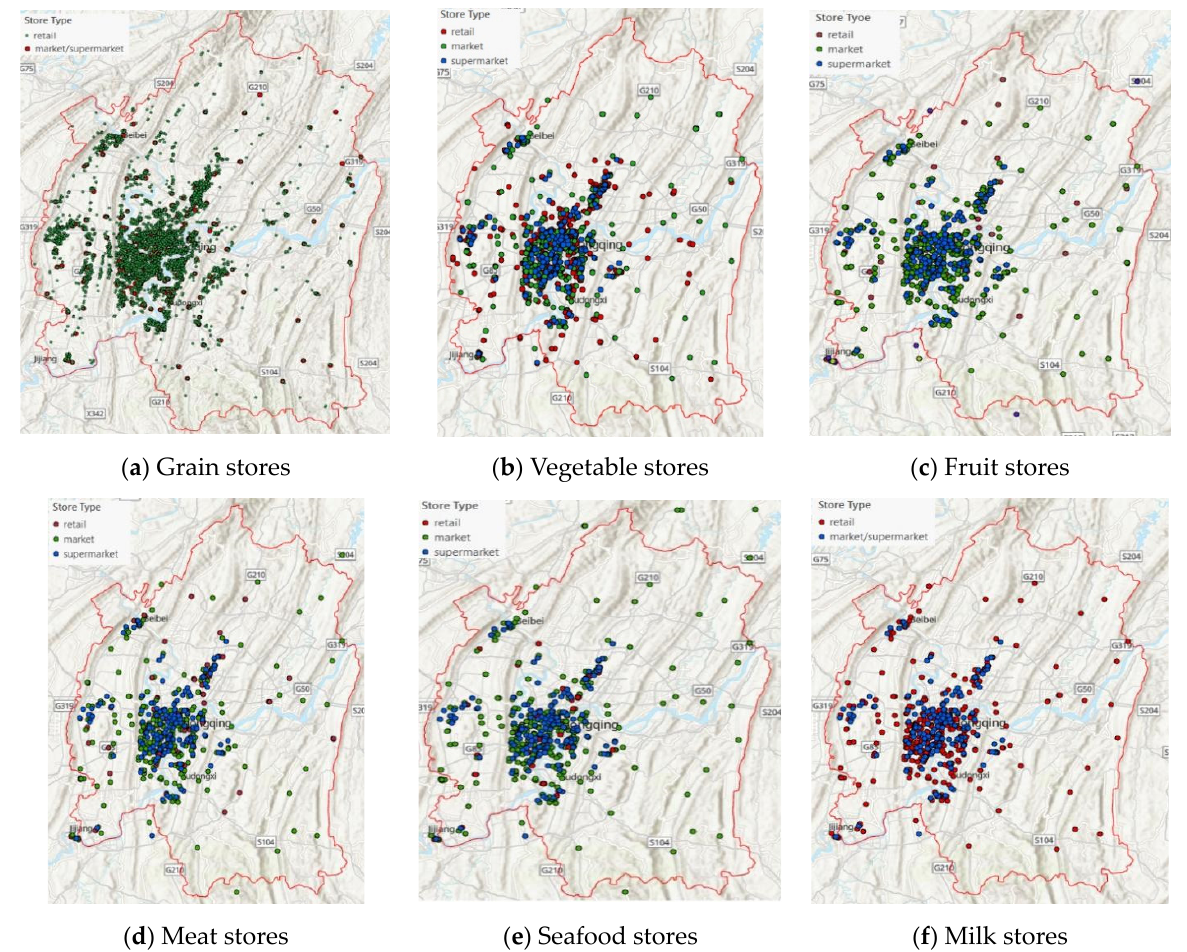
Figure 2. Spatial distributions of stores in Chongqing selling different categories of food products.